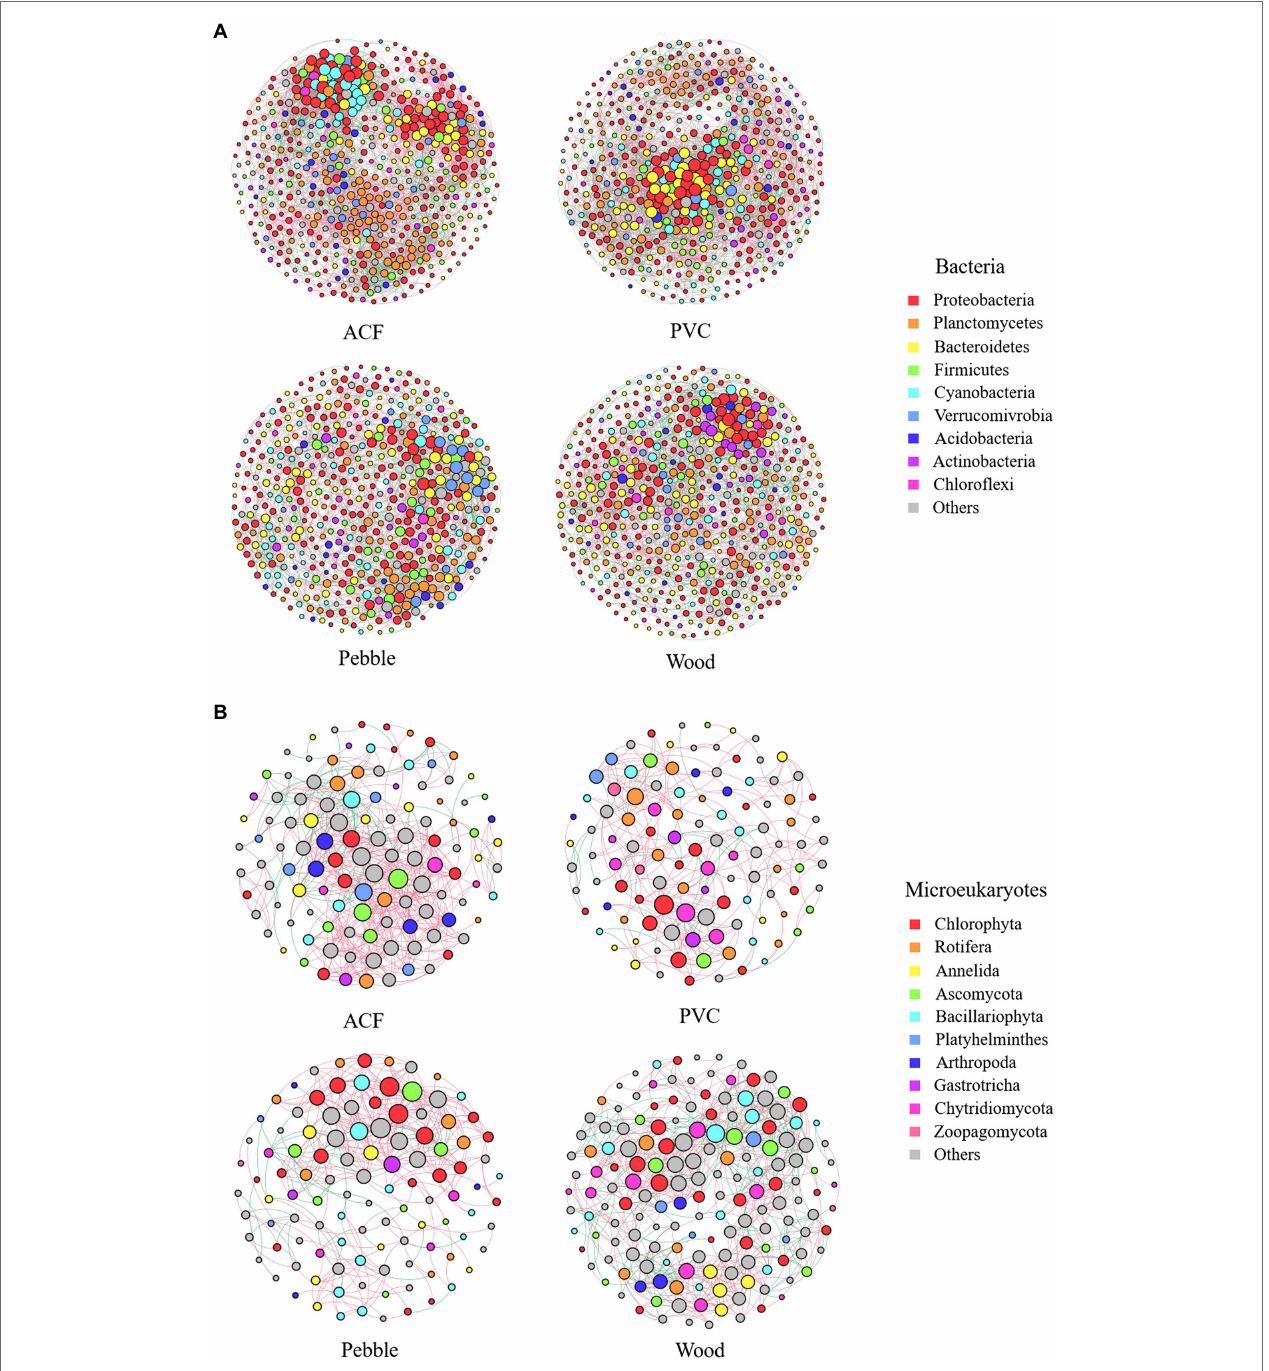
FIGURE 3 | Networks of bacteria (A) and microeukaryotes (B) at phylum level for the biofilm samples colonised on artificial (ACF and PVC) and natural (pebble and wood) substrates. Each point represents an independent bacterial or microeukaryotic operational taxonomic unit (OTU), node size is proportional to the relative abundance, red edges represent positive relationships, and green edges represent negative relationships among the OTUs in the